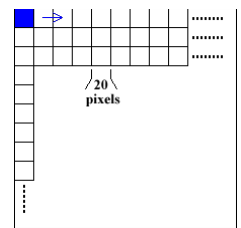
Figure 2. White coloured regions